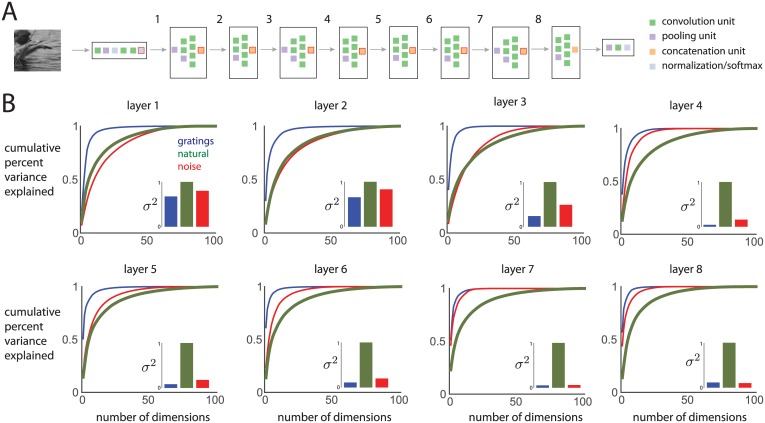
Dimensionality of activity in different layers of a deep convolutional neural network (CNN).A: The CNN comprised different layers (black outline boxes), where each layer comprised a group of units that performed specific operations, such as convolution, pooling, concatenation, and normalization. For each of the red-outlined units, we assessed the dimensionality of the activity of 100 filters. B: Dimensionality and variance of model responses in each layer to movies, computed in the same manner as in Fig 3C.